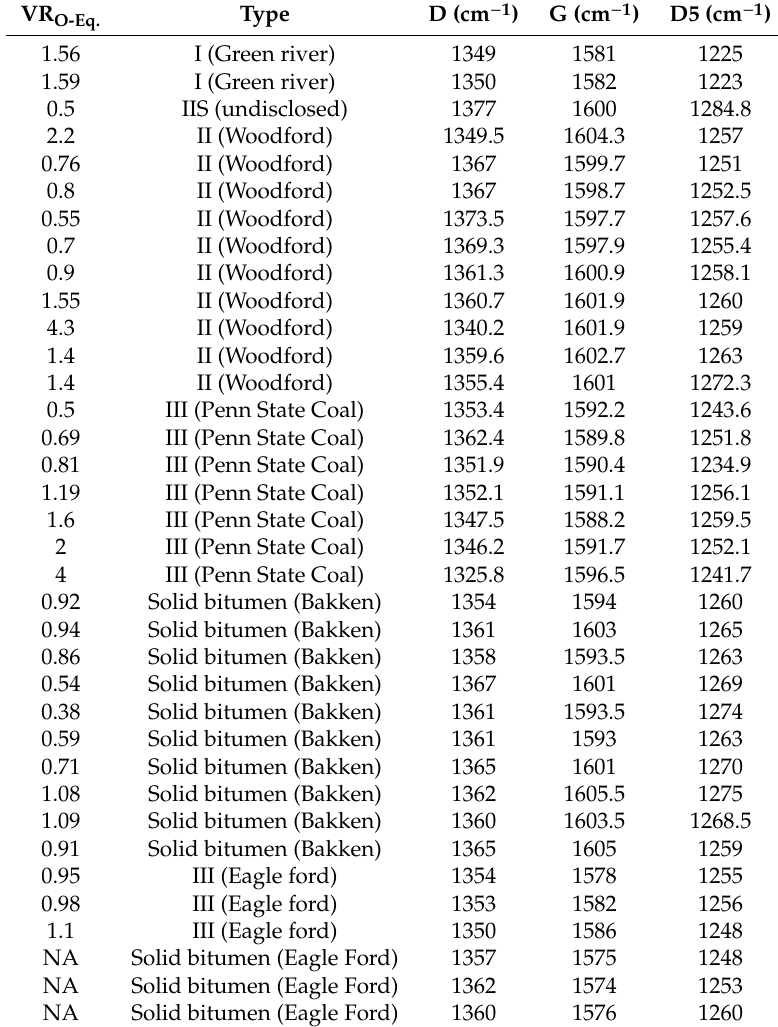
Table 3. Information on the sample band spectral